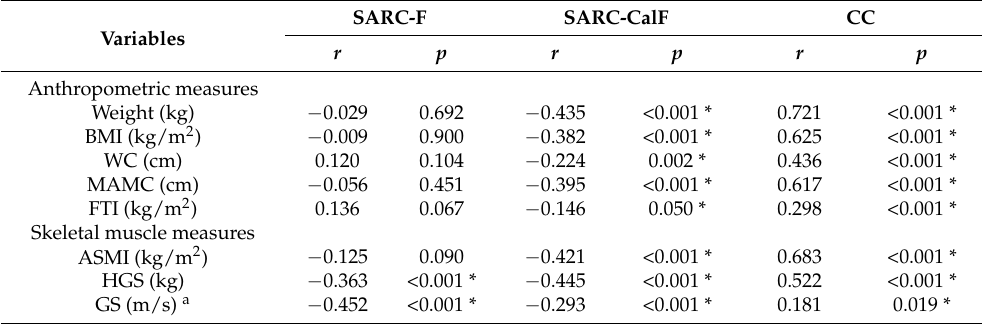
Table 3. The correlations of SARC-F, SARC-CalF, and CC with anthropometric and skeletal muscle measurements.